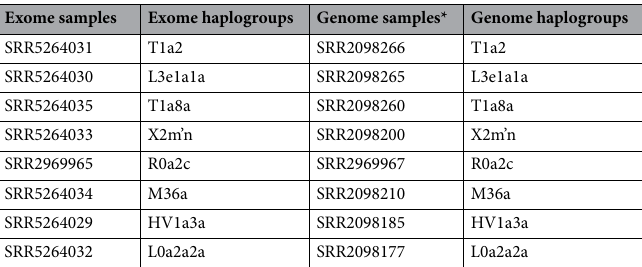
Table 2. Mitochondrial haplogroup assignment comparison between whole exome and whole genome. *Sample ID are NCBI SRA sample number for Qatari whole exome and genome samples.